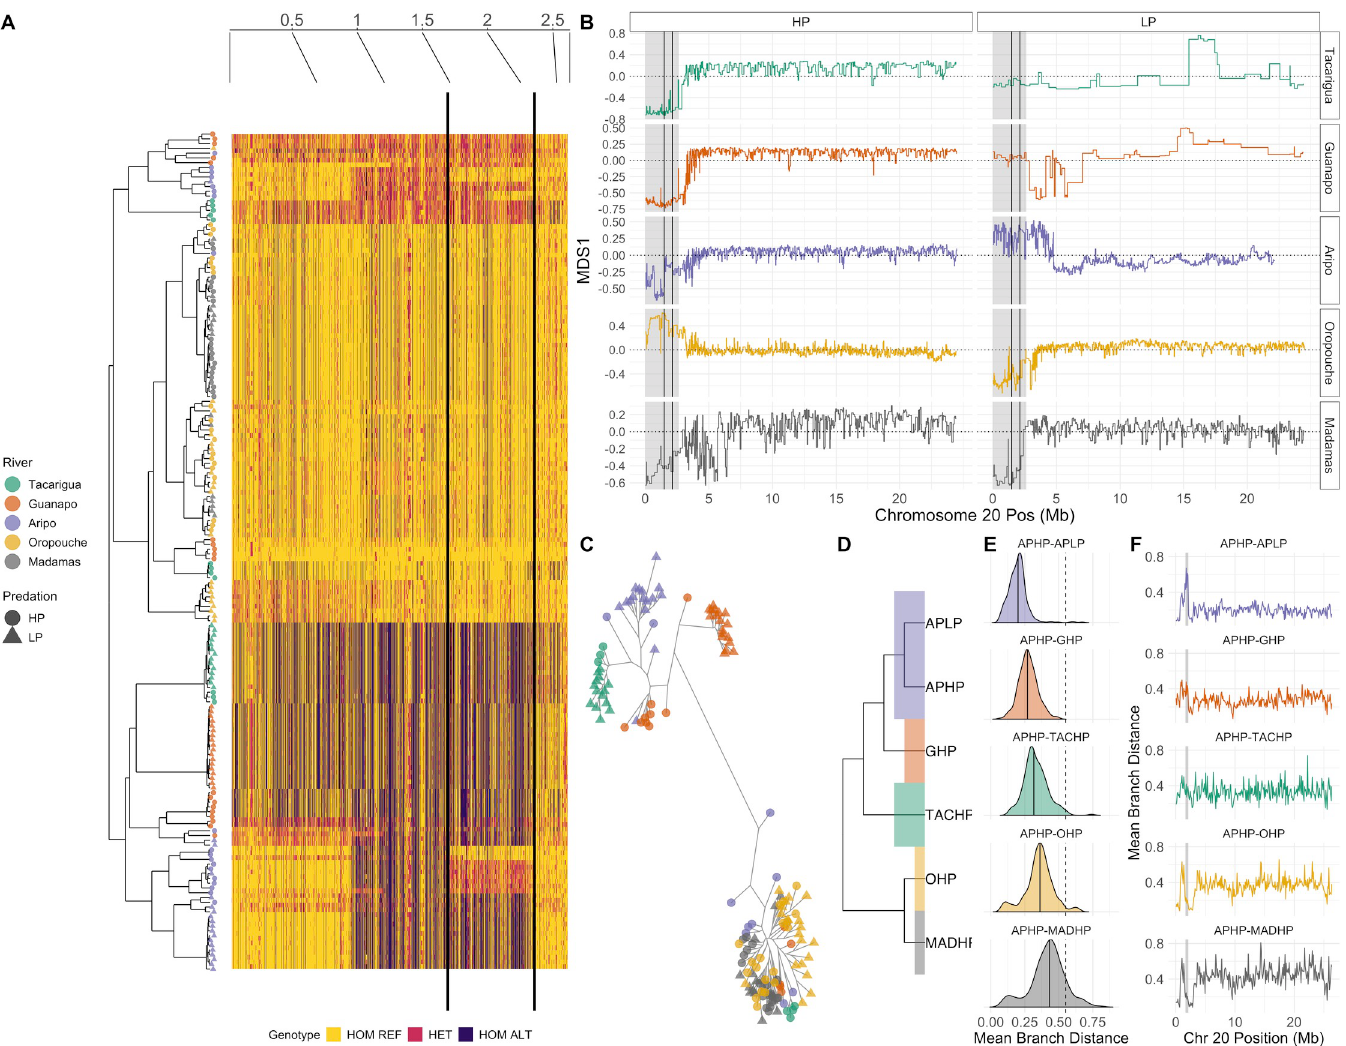
Fig 4. Evidence of divergence along the CL haplotype (ALT alleles, chr20:1–2633448). Genotypes for each individual plotted according to hierarchical clustering of PCA (A). Solid black lines denote the CL-AP region, corresponding to the strongest peak of HP-LP association in the dataset. (B) The CL haplotype region (shaded grey) shows evidence of segregated local ancestry in comparison to the rest of chromosome 20, according to MDS scores derived from local PCA. The CL-AP region is again shown between solid black lines. MDS1 = 0 is shown as a dotted line in each panel. A lack of signal on MDS1 for the CL region in Guanapo LP (GLP) and Tacarigua LP (TACLP) reflects that this region is fixed. (C) Unrooted maximum-likelihood tree of homozygous individuals (haplogroups) across the CL-AP region, highlighting a major phylogenetic branch separating Caroni LP individuals from both Caroni HP individuals (homozygous for the REF haplotype) and populations from outside the Caroni drainage. (D-F) Branch length analysis of CL-AP region relative to the whole of chromosome 20. Density distributions (E) show mean branch lengths between populations in 100kb windows across chromosome 20 (F), with the median highlighted in each. The mean branch length between the REF and CL haplotype at the CL-AP region in Aripo is marked on all density distributions as a dashed line. Density distributions are ordered vertically according to increasing phylogenetic distance, as summarised in the adjoining tree (D). The CL-AP region is highlighted in panel F as a grey